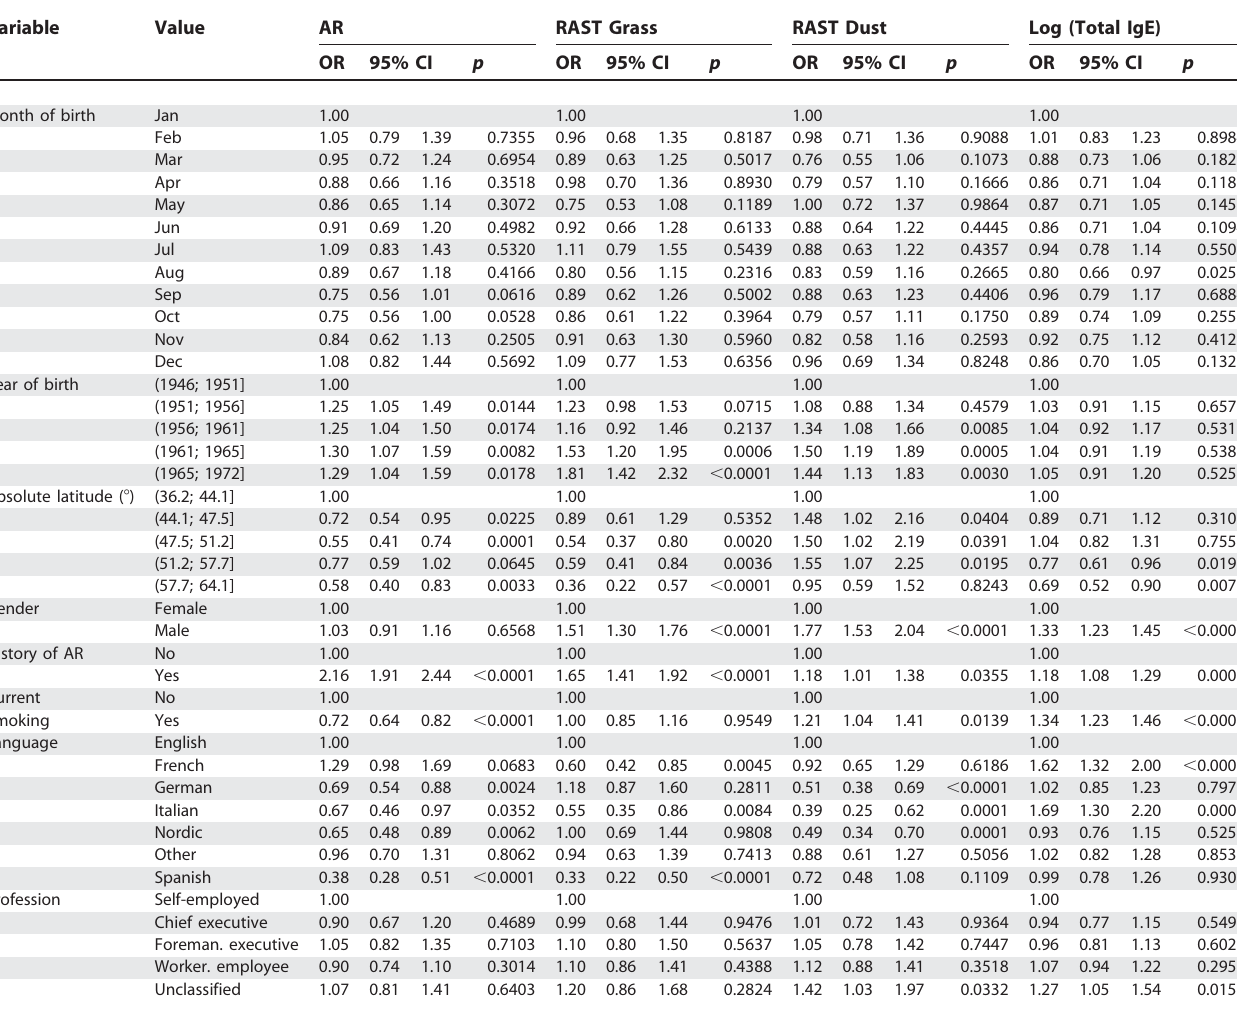
Table 3. Adjusted Risk for AR, Total IgE, and Sensitization against Grass or House Dust Mite in ECRHS I Main Study